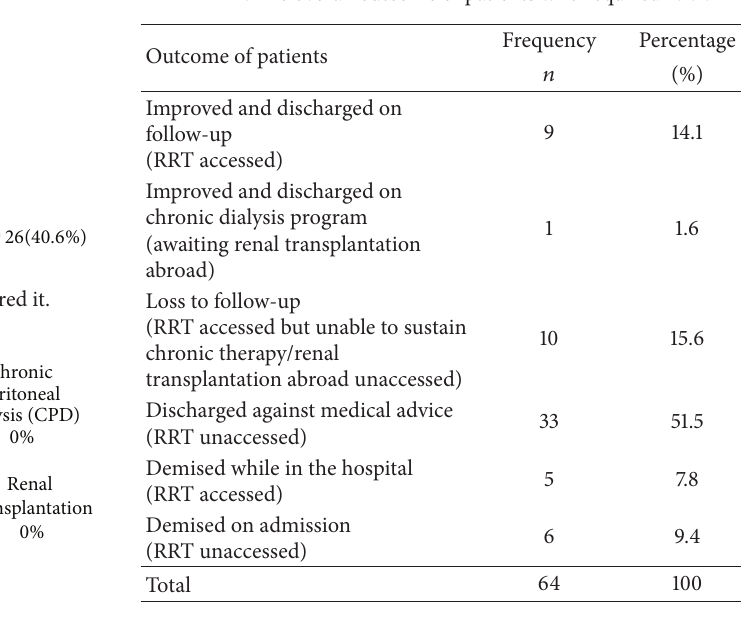
Table 4: The overall outcome of patients who required